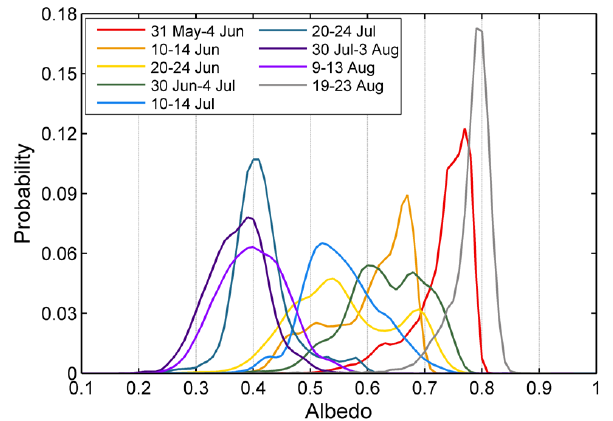
Figure 7. 100 × 100 px 5-day averages over the 2013 melt season. Every other 5-day average line is plotted.